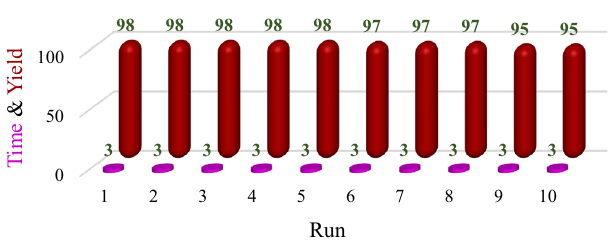
Figure 6. Reusability of the biochar/Fe 3 O 4 –Ag nanocatalyst for aldehydes and ketones reduction